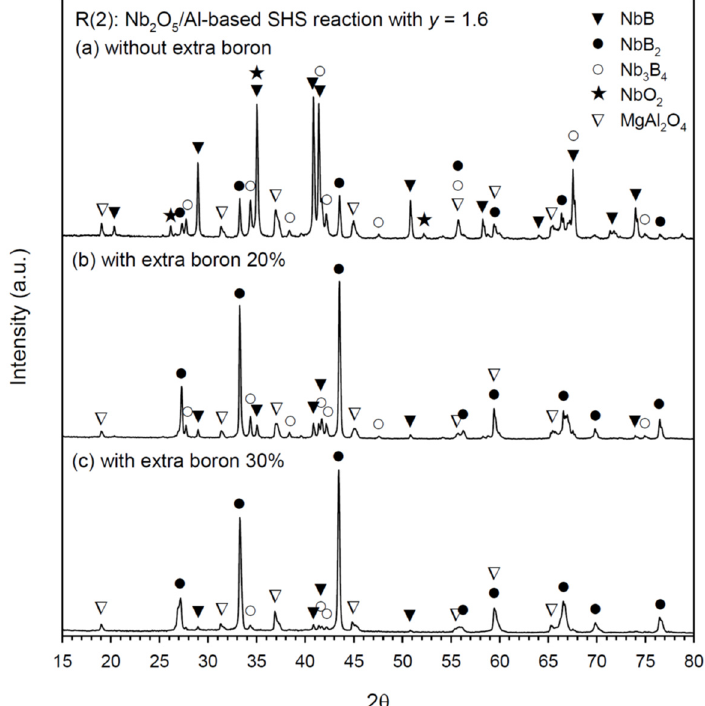
Figure 7. XRD patterns of NbB 2 –MgAl 2 O 4 composites synthesized from Reaction (2) of y = 1.6 under conditions: ( a ) without extra boron, ( b ) with extra boron 20%, and ( c ) with extra boron 30%.